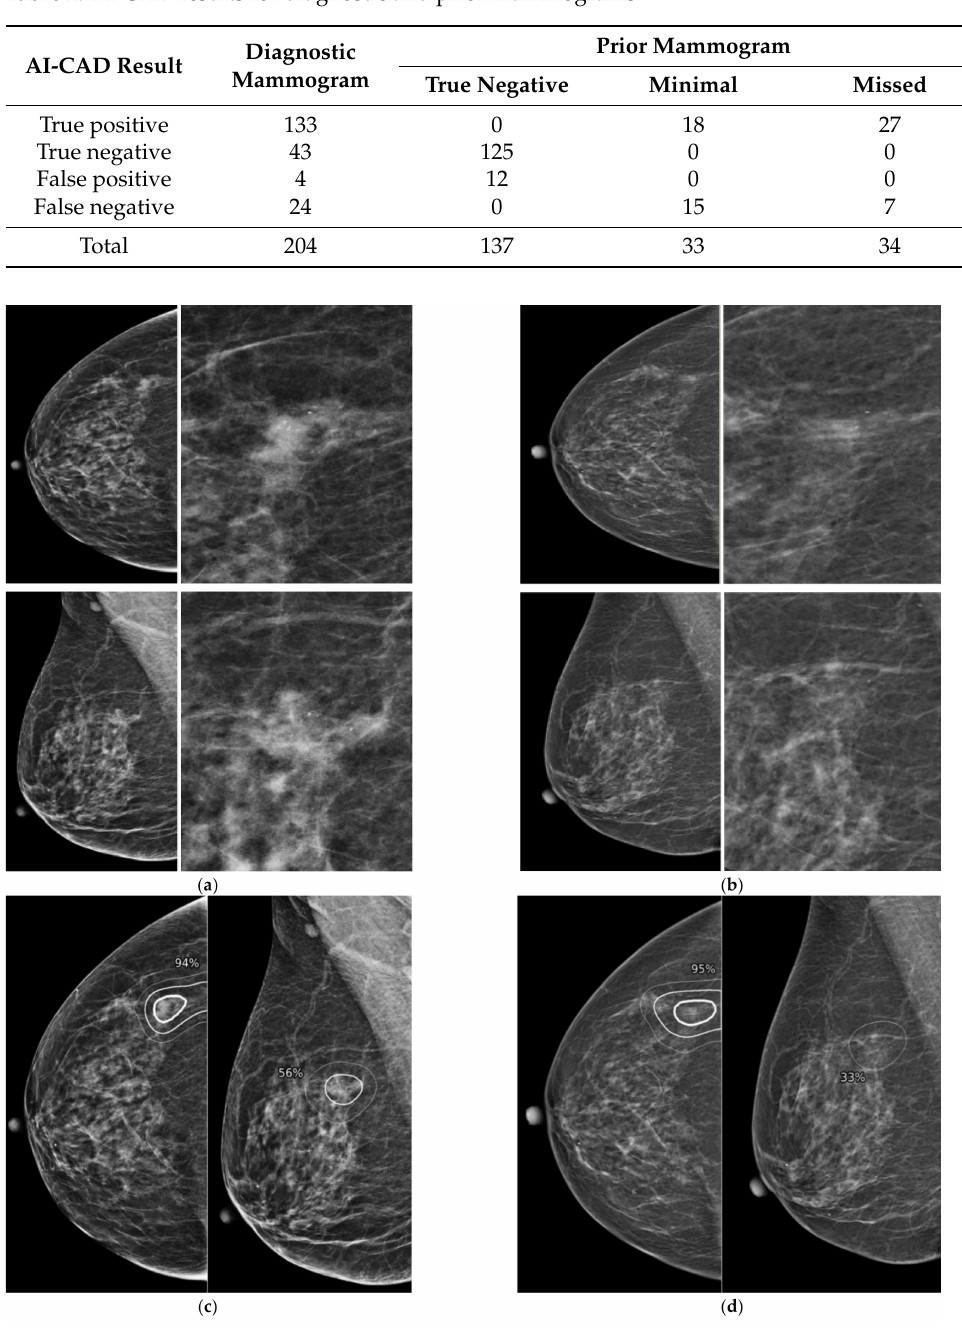
Figure 2. Representative case of missed cancer detected by AI-CAD. A 67-year-old woman had a focal asymmetry with increased number of calcifications in diagnostic mammogram ( a ). After biopsy, this lesion was confirmed as invasive carcinoma. When the two radiologists reviewed the prior mammogram performed 12 months ago ( b ), asymmetry visible on CC view and several calcifications were retrospectively detected at the same location. When the AI-CAD was retrospectively applied, the AI-CAD identified the exact location of lesion in the diagnostic mammogram ( c ) and prior mammogram ( d